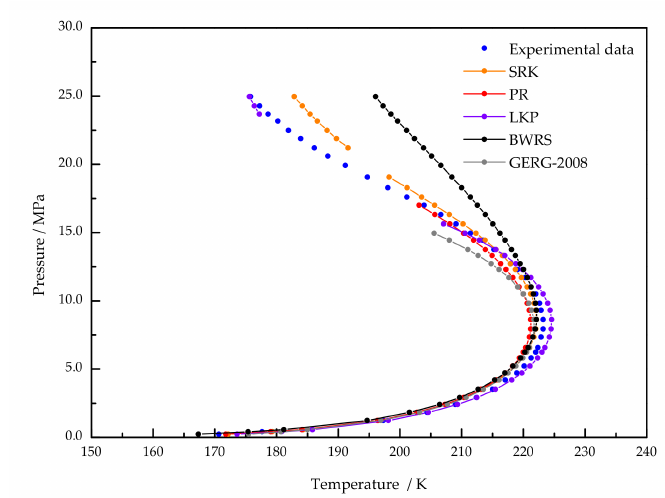
Figure 2. Experimental and calculation results of dew points for Sample 1.